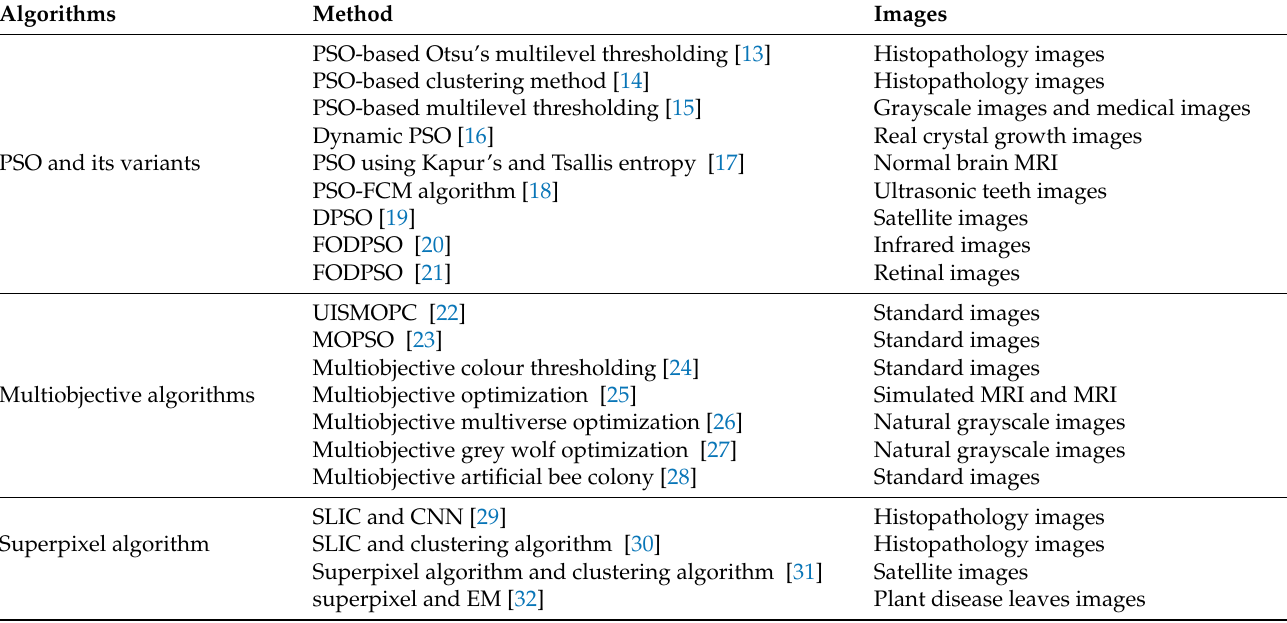
Table 1. The summary of the related works in image segmentation.